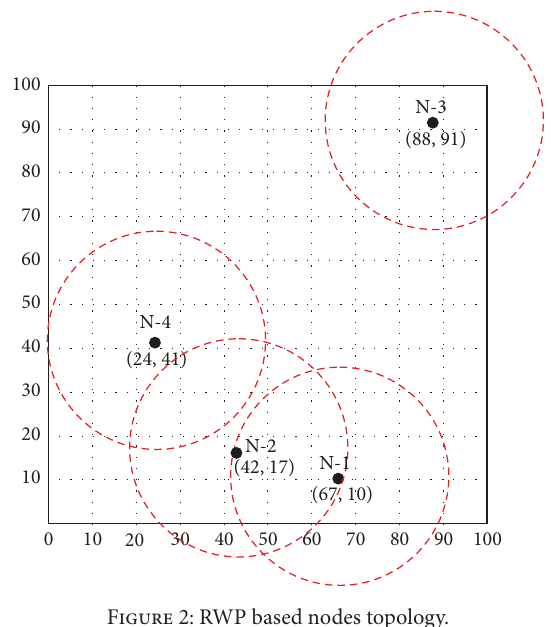
Figure 2: RWP based nodes topology.